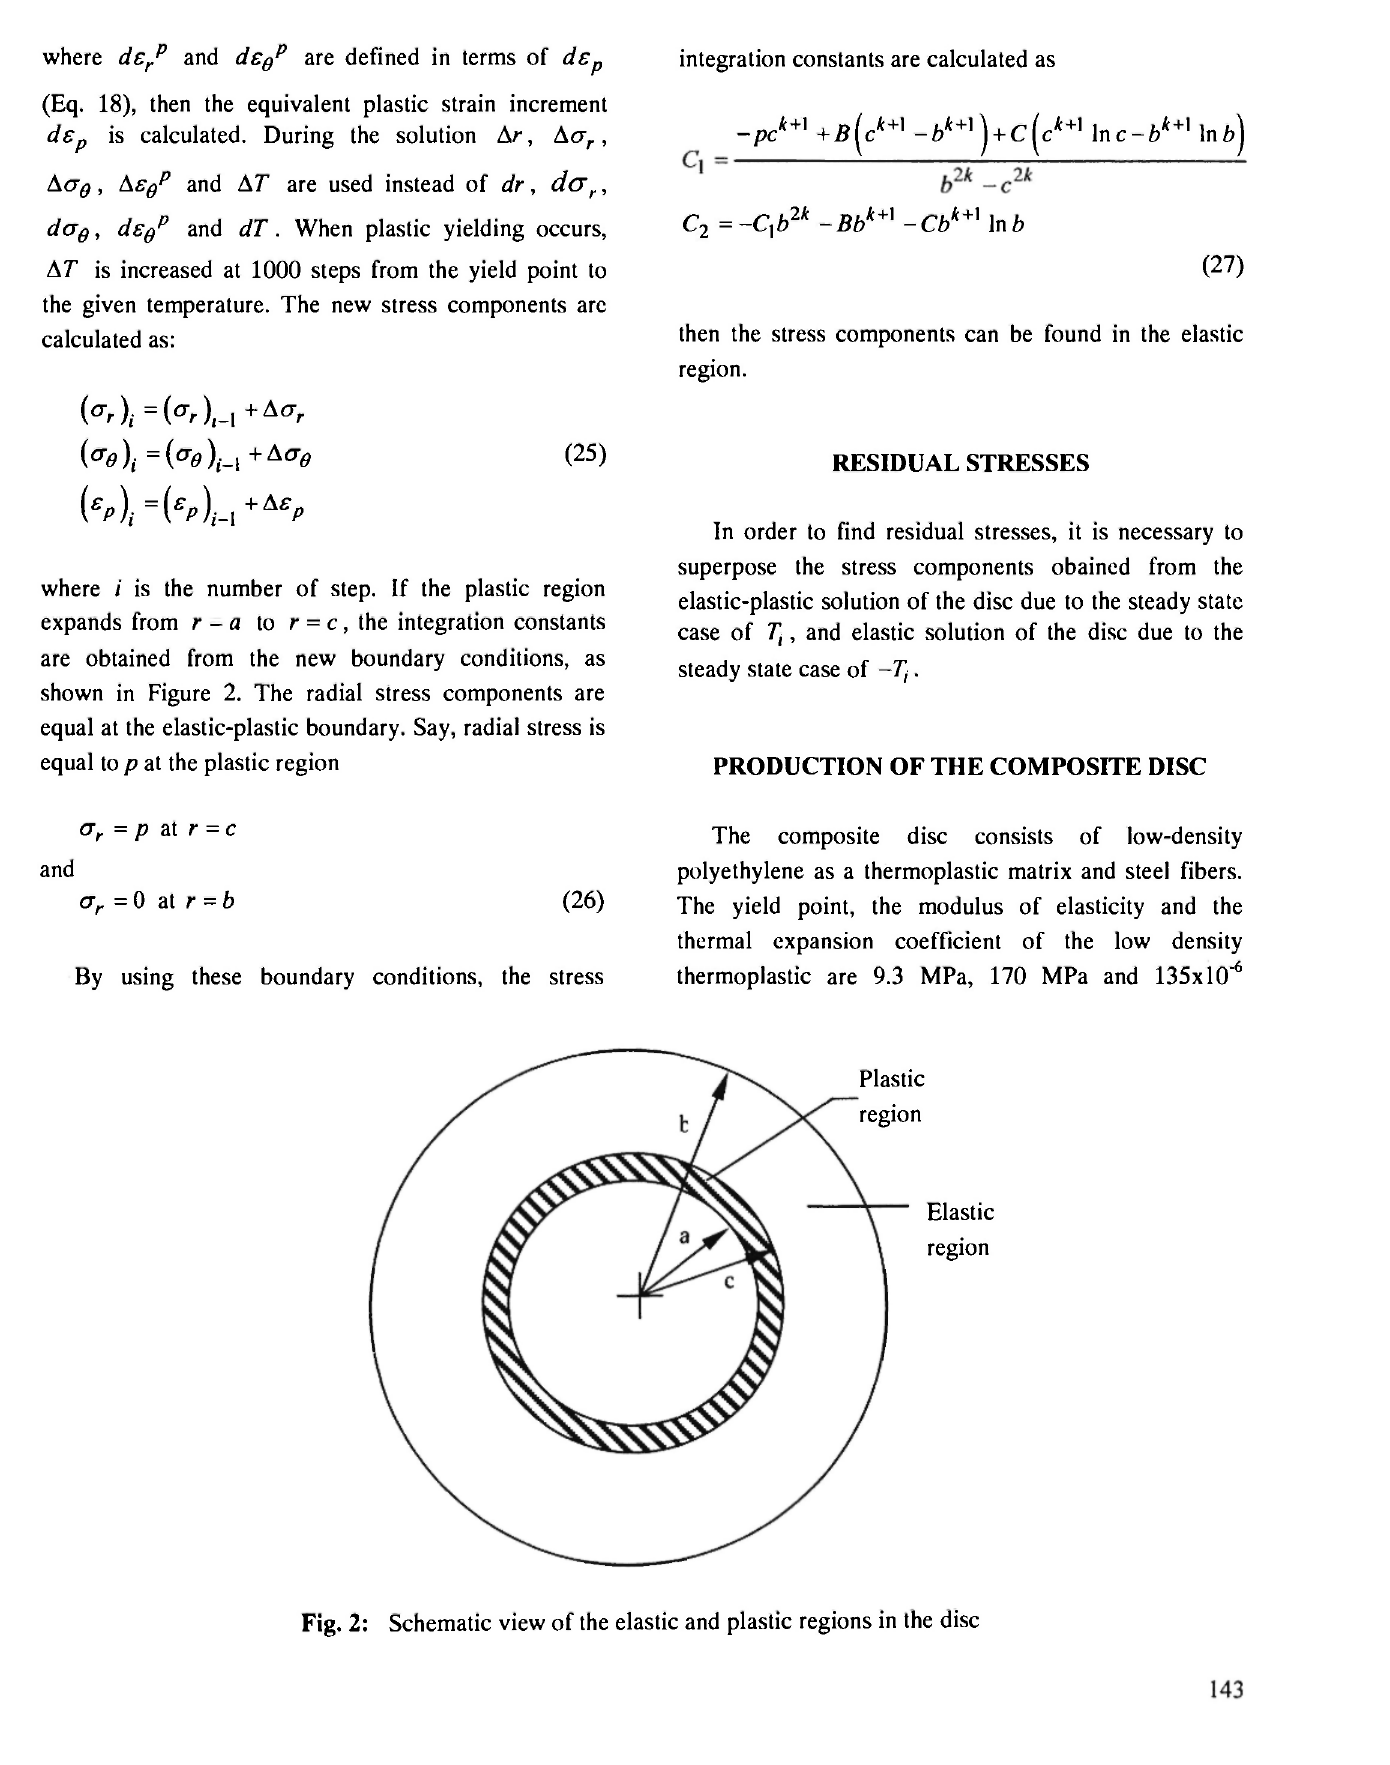
Fig. 2: Schematic view of the elastic and plastic regions in the